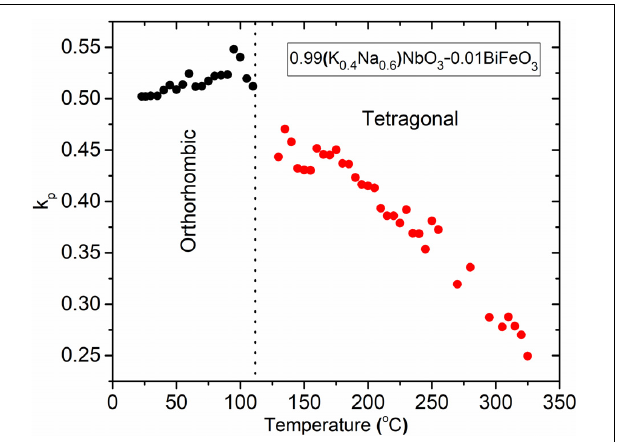
FIGURE 9 | k p as a function of temperature for x = 1